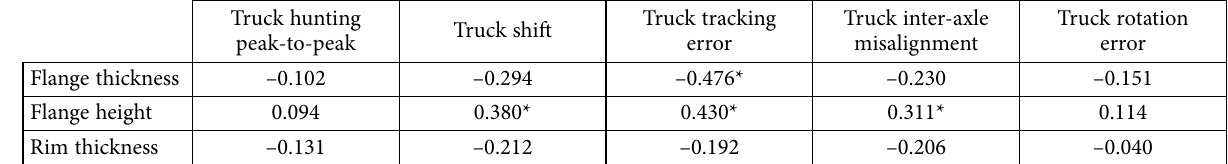
Figure 1. Plot of rim thickness in inches of 8 wheels in the same equipment over time, where: L – indicates the left wheel; R – indicates the right wheel, and red dashed line represents the maintenance time Table 2. Correlations of wheel profile measurements and truck measurements